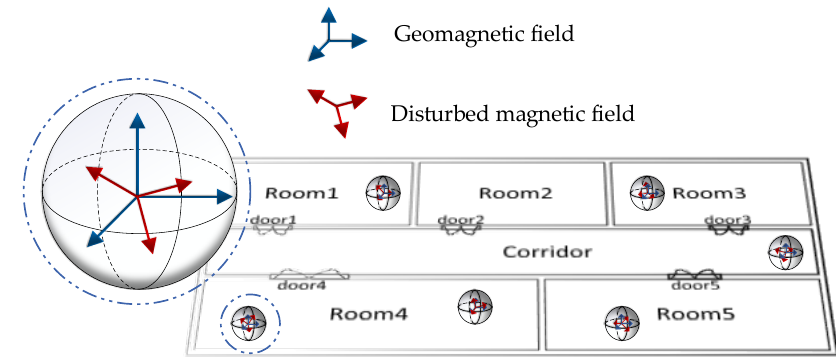
Figure 1. The random distribution of magnetic interference sources indoors.